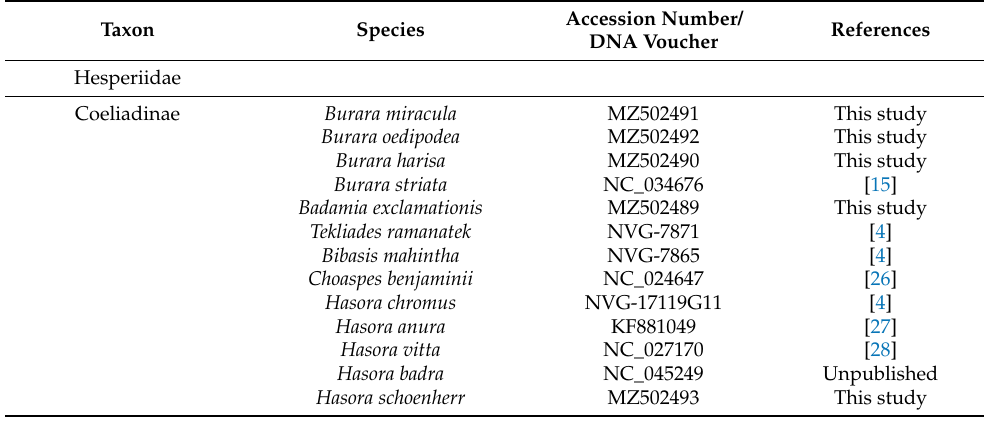
Table 1. Classification and origins of the mitochondrial genome used in this